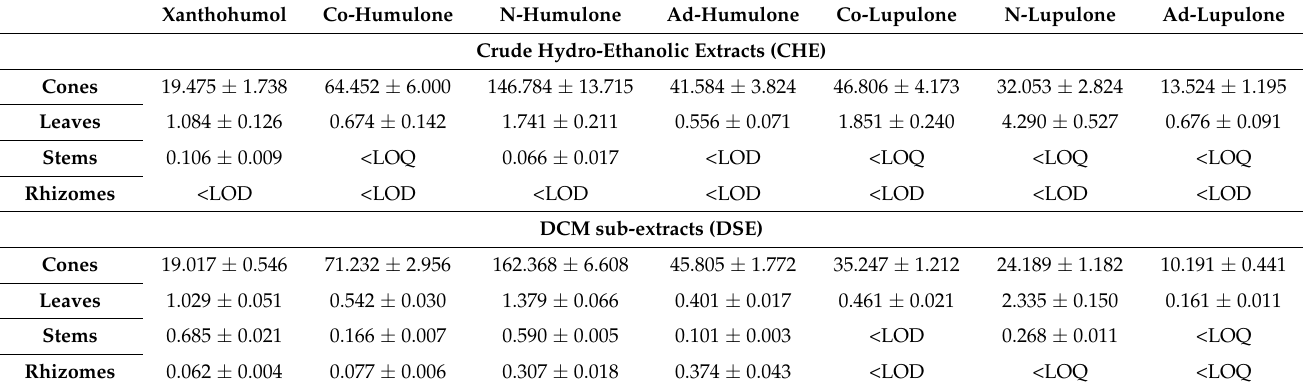
Table 3. Content (in µ g · mg − 1 ) of prenylated chalcones and acylphloroglucinols in (A) Crude hydro- ethanolic extracts (CHE) and (B) DCM sub-extracts (DSE) of different hop parts ( n = 3, mean ± SD).